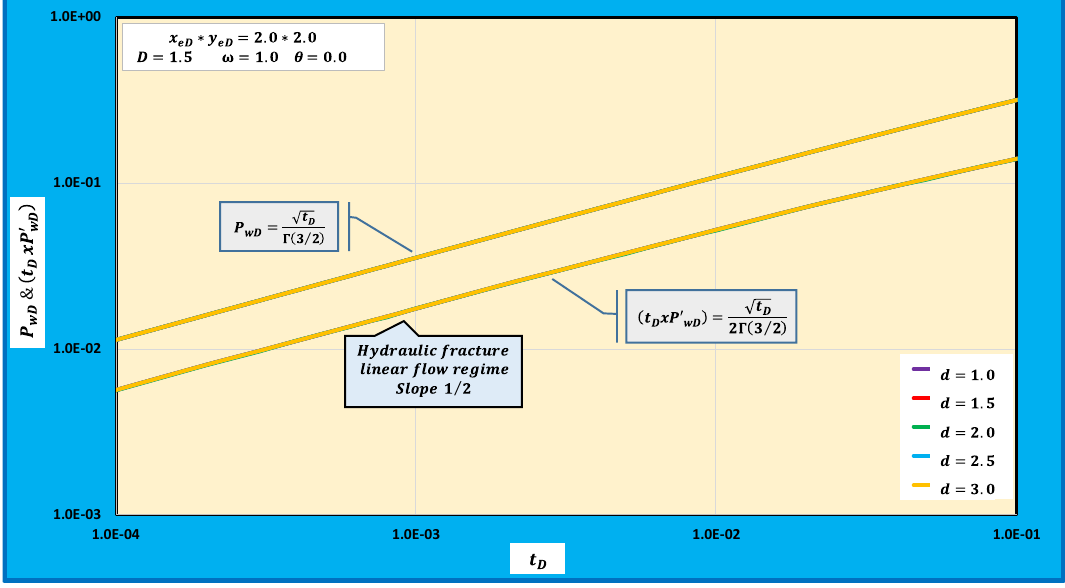
Fig. 19 Pressure and pressure derivative of hydraulic fracture linear flow